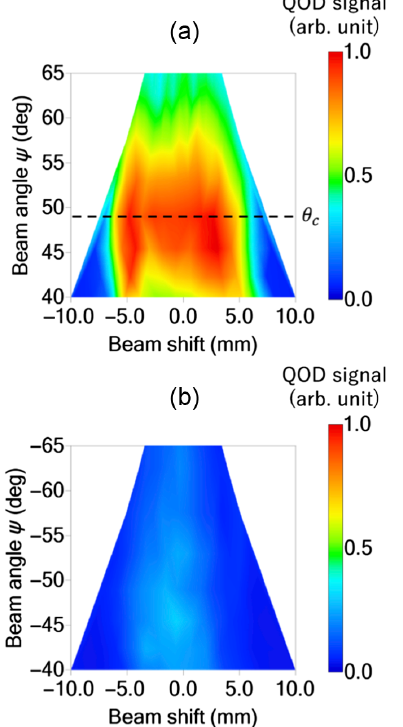
FIG. 4. THz intensities on the tilt angle versus beam shift plane. The QOD signal, indicated by the color bar, represents the THz intensity measured by the QOD, which is normalized by the maximum value. The signal intensity increased at the Cherenkov radiation angle (a) but did not change at the reverse angle (b). The beam shift on the horizontal axis refers to the shift of the electron bunch